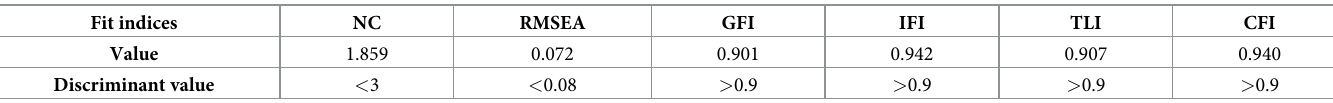
Table 11. The first-order model fit of